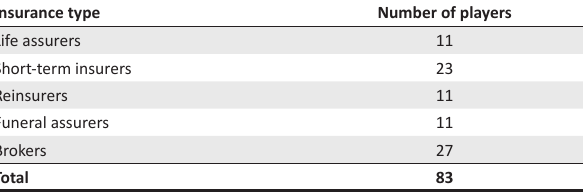
TABLE 1: Number of insurance players by